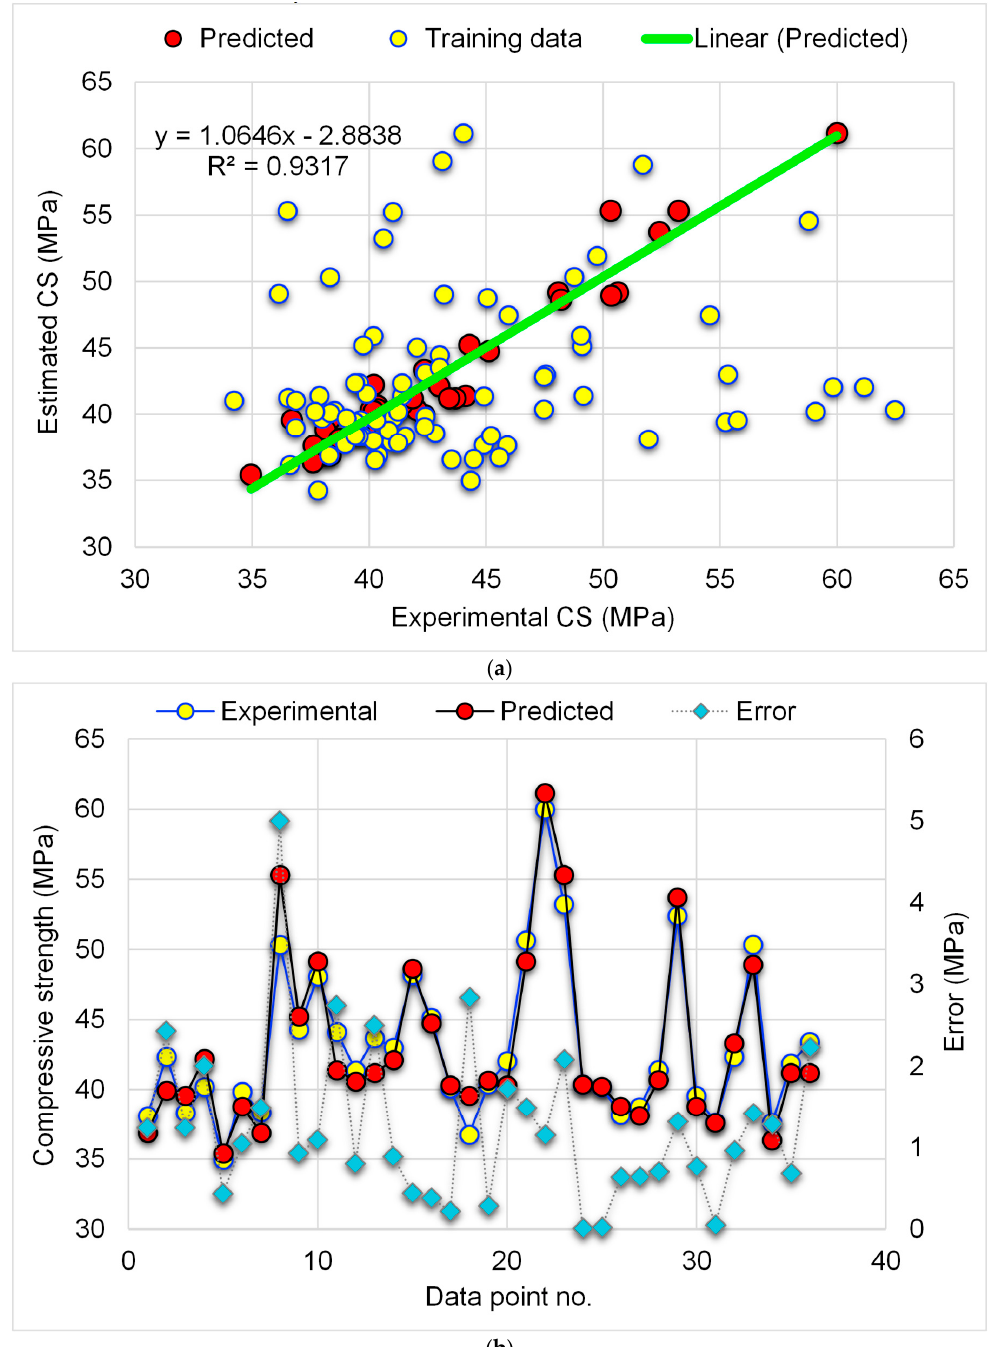
Figure 7. GBR-CS model: ( a ) correlation amongst experimental and predicted CS; ( b ) distribution of experimental and predicted CS and error values.